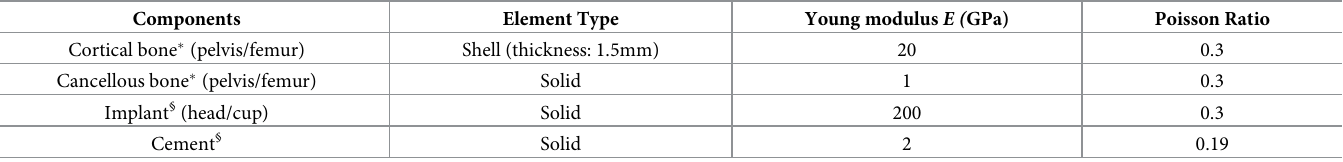
Table 1. Material properties of the FE model.